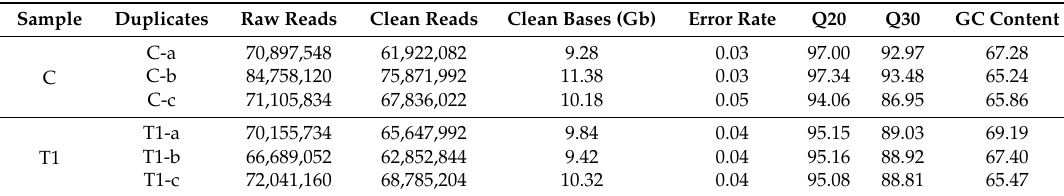
Table 1. Summary of circRNA sequencing